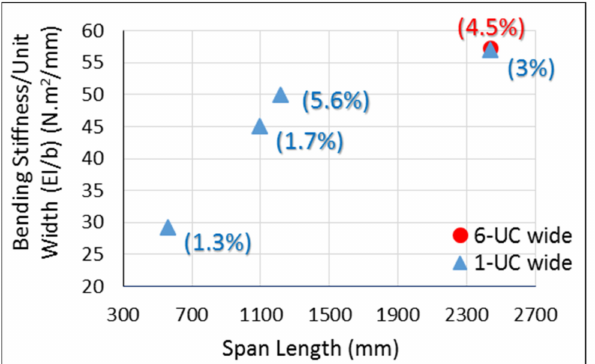
Figure 8. Bending stiffness per unit width for one-layered core sandwich panel (values in parenthesis are